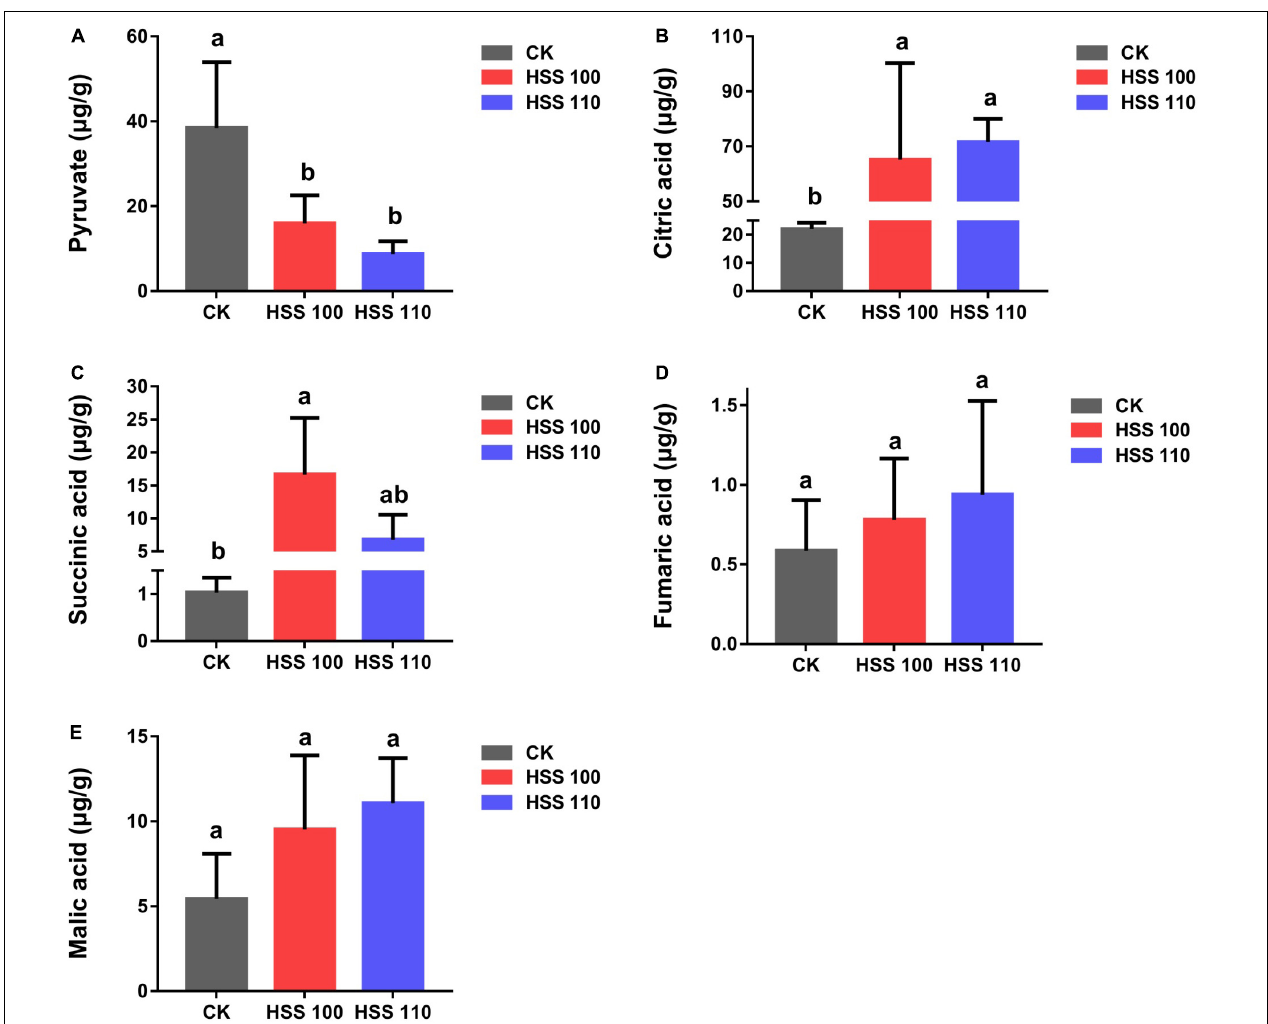
FIGURE 6 | Effects of different conditions on P. haitanensis organic acid contents. (A) Pyruvic acid content. (B) Citric acid content. (C) Succinic acid content. (D) Fumaric acid content. (E) Malic acid content. Data are presented as the mean ± SE for at least three independent biological replicates. Different letters above the bars indicate significant differences at P < 0.05 as determined by a one-way ANOVA followed by Tukey’s test.